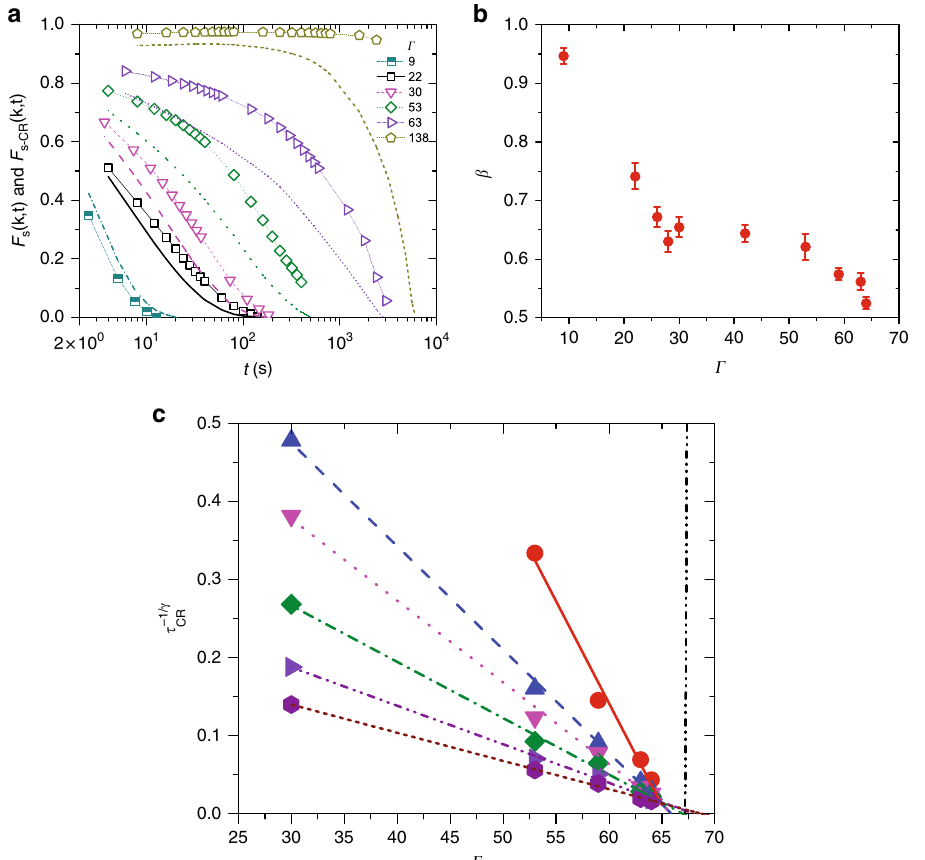
Fig. 2 Testing predictions of MCT on a sphere. a The normal self-intermediate scattering functions F s ( k , t ) (lines) and the cage-relative self-intermediate scattering function F s − CR ( k , t ) (symbols) for various Γ values. At low Γ , since the cage around the particle is itself quite mobile, when computing the cage- relative measure, a random displacement due to cage motion also contributes to the particle displacement over and above that due to its Brownian motion. Thus, F s − CR ( k , t ) decays faster than F s ( k , t ). As Γ is increased and the cages become more rigid, this effect diminishes and the decay of F s − CR ( k , t ) is slower than F s ( k , t ). b Variation of the stretching exponent β , obtained from fi ts to F s − CR ( k , t ), with Γ . The error bars represent the standard error (SE) and are obtained from fi ts to the data. c τ (cid:1) 1 = γ versus Γ for various wavevectors k . k = 3.69 (red circles), k = 2.99 (blue triangles), k = 2.73 (magenta triangles), k = CR 2.32 (olive green squares), k = 1.90 (violet triangles), and k = 1.53 (wine hexagons). The vertical black line shows the mode-coupling glass transition. The power-law exponent was found to be γ =